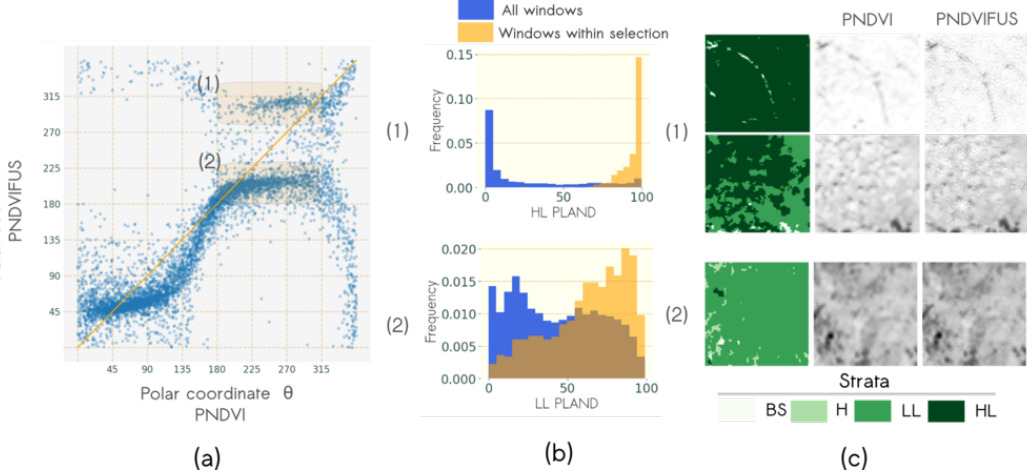
Figure 10. Co-variation of textural gradients derived from NDVI of Pléiades before and after pansharpenning and: ( a ) Scatterplot of angular coordinates with two types of angular variations highlighted in orange: (1) from [180 ◦ , 315 ◦ ] to [280 ◦ , 330 ◦ ], (2) from [180 ◦ , 315 ◦ ] to [200 ◦ , 250 ◦ ]; ( b ) histograms of characteristic vegetation structure of each angular variation type, metric distribution is plotted in blue when considering all windows and in orange when considering only windows within the variation type angular range values, and ( c ) typical windows of each variation